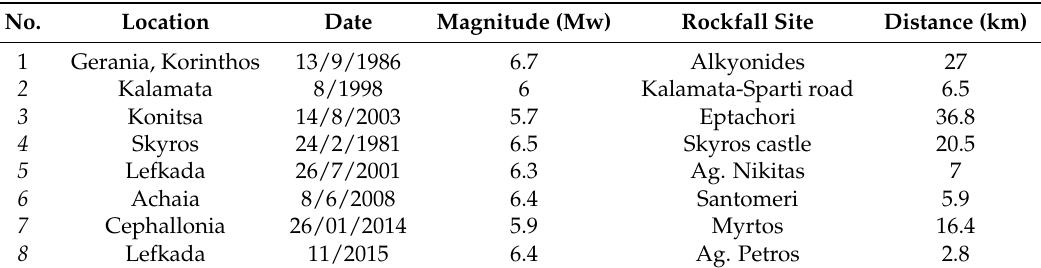
Table 2. Main coseismic rockfalls in Greece.